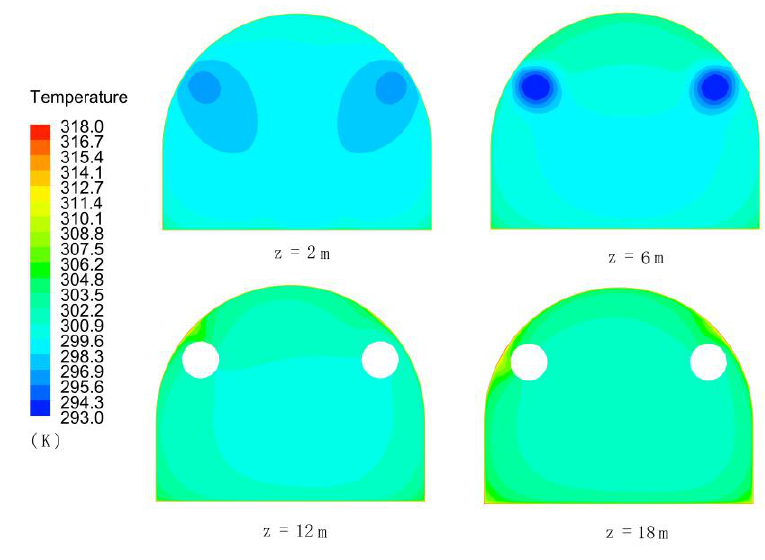
Figure 13. Model 4 section temperature distribution.